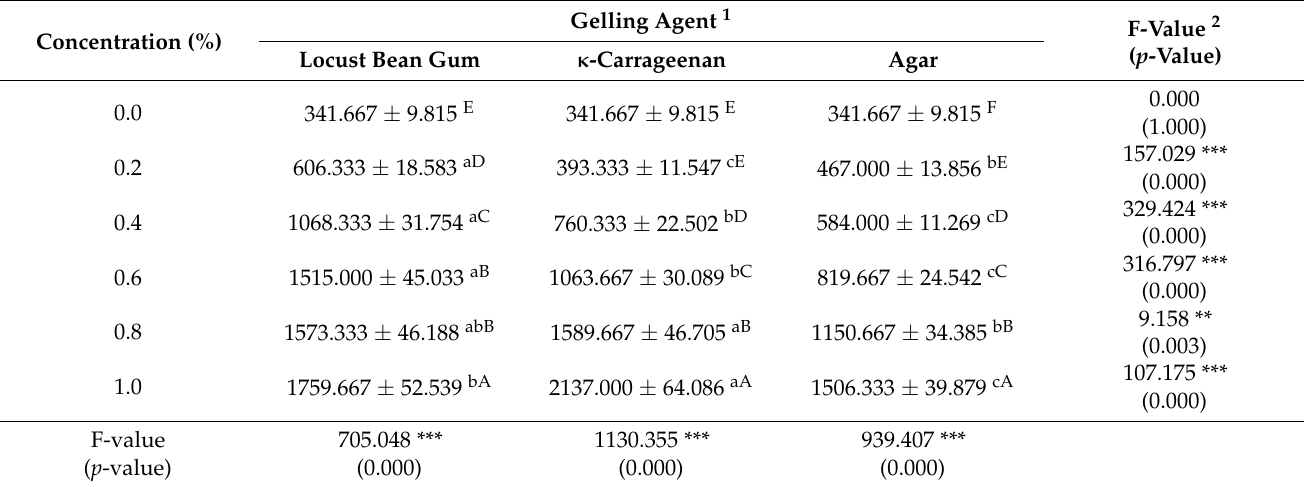
Table 4. Viscosity of custard according to the concentration of gelling